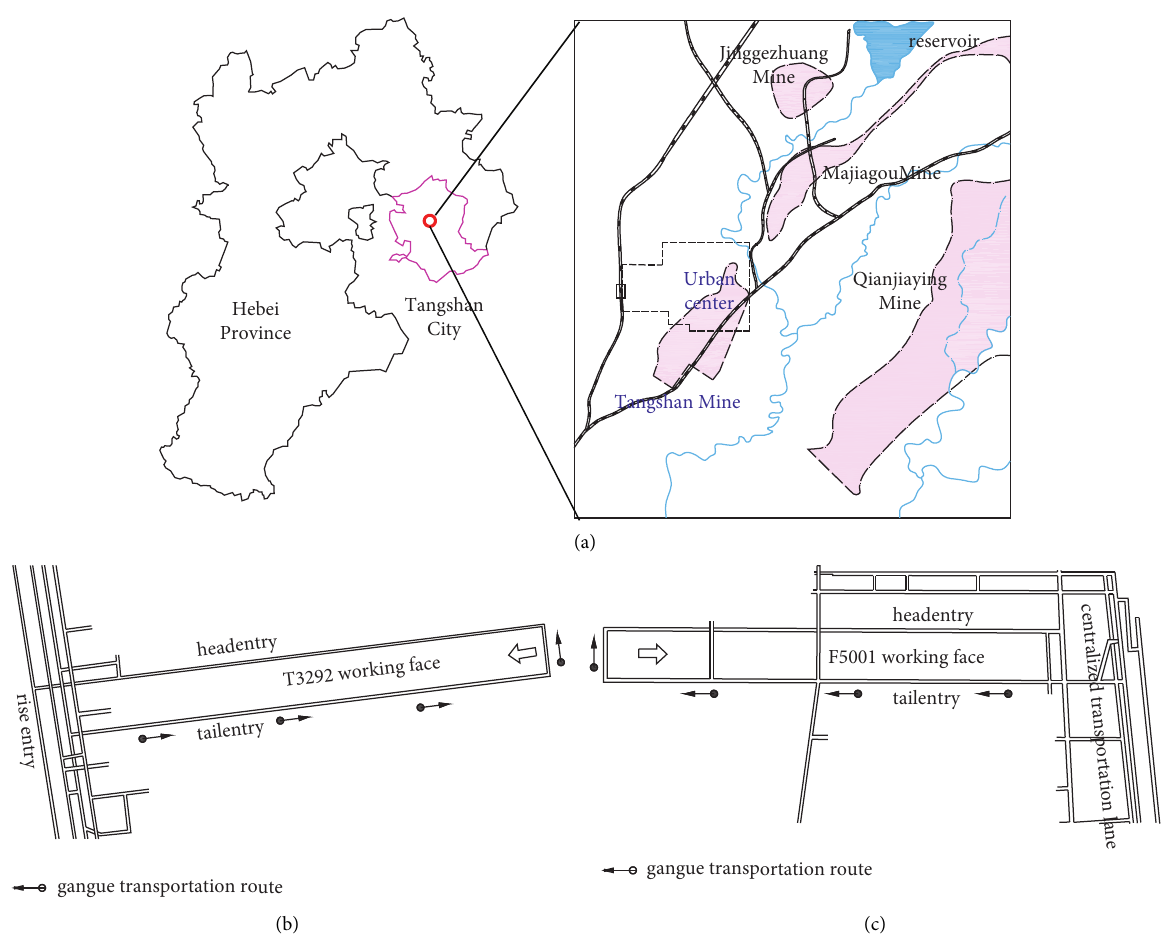
Figure 1: Geographical location and working face distribution of Tangshan mine: (a) location of Tangshan mine, (b) layout of T3292 working face, and (c) layout of F5001 working face.